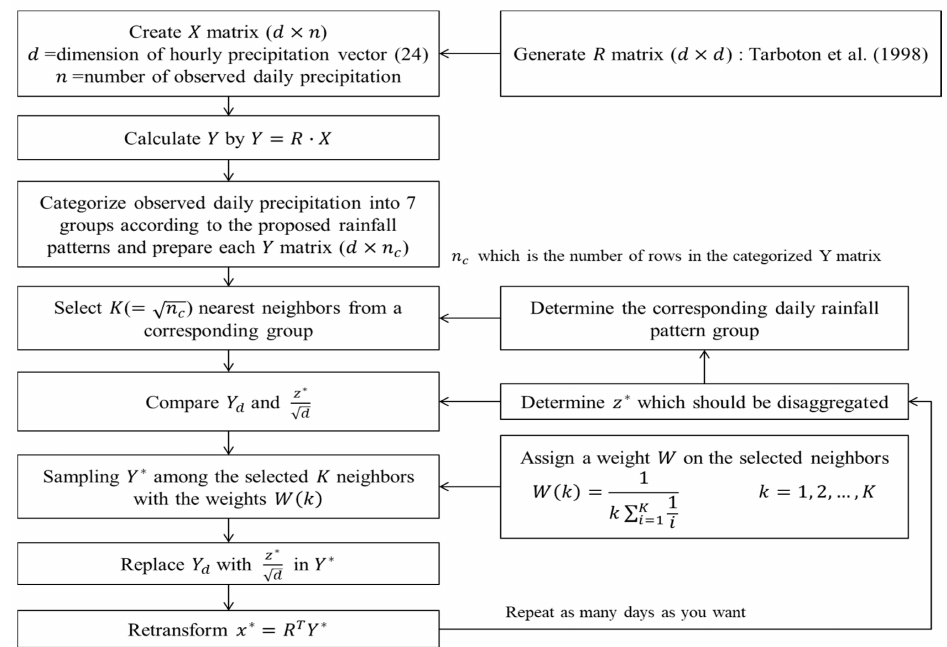
Figure 2. Flowchart of the proposed disaggregation method.